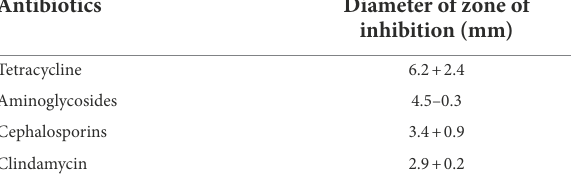
TABLE 2 Antimicrobial susceptibility